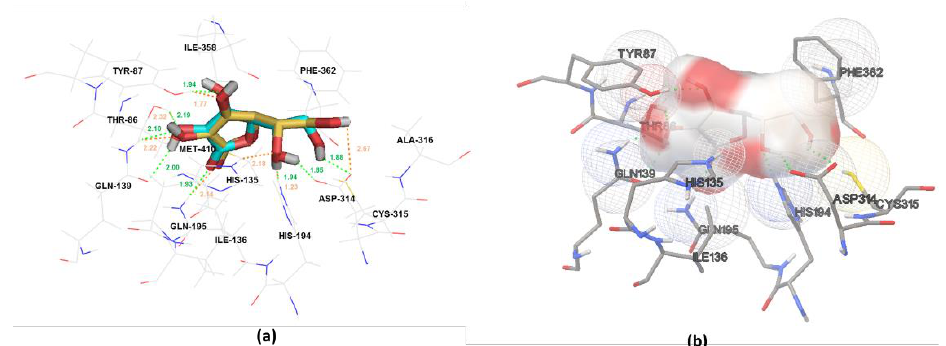
Figure 6. Ascorbic binding modes with sodium-dependent vitamin C transporter-2 (SVCT2) (pdb code: 4RP9). ( a ) Superimposition of ascorbic acid crystal pose (yellow) and dock pose (cyan); ( b ) van der Waals interaction of the residues around the active sites, with ascorbic acid dock pose.